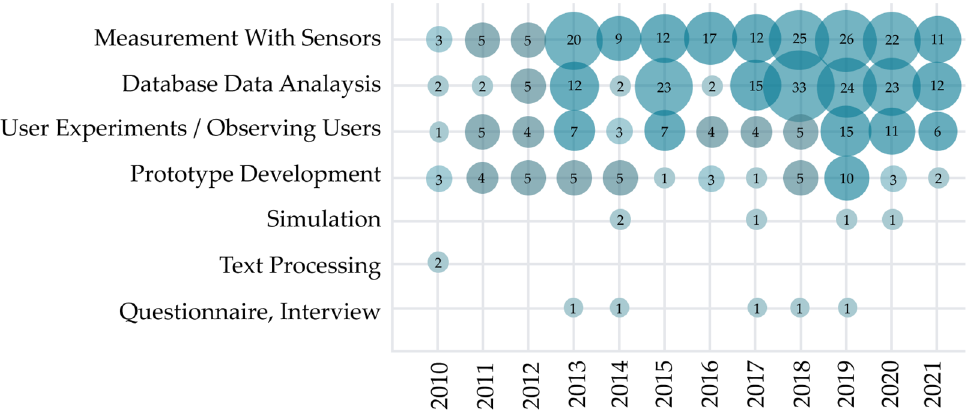
Figure 10. Number of studies by year and data collection method.